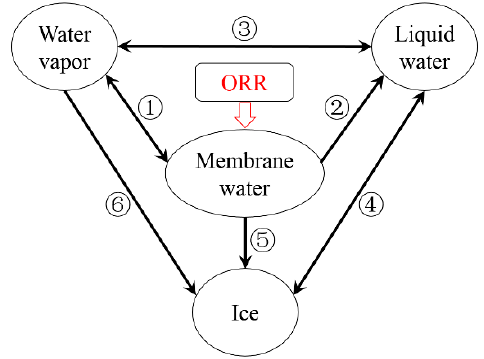
Figure 2. The phase change and mass transfer process of water in PEFC [35].